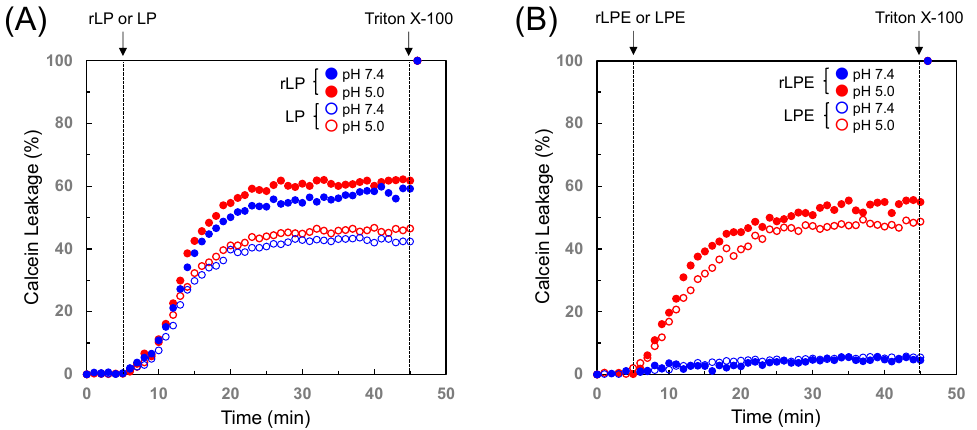
Figure 2. Membrane lytic activities of the LP and rLP polypeptides ( A ) and the LPE and rLPE polypeptides ( B ). A typical calcein-leakage assay with the normal- and the retro-polypeptides was carried out at both physiological (pH 7.4) and endosomal (pH 5.0) conditions. Calcein leakage from EggPC liposomes was measured every 0.5 or 1 min a following the addition of 20 μ M of polypeptide at 25 °C.